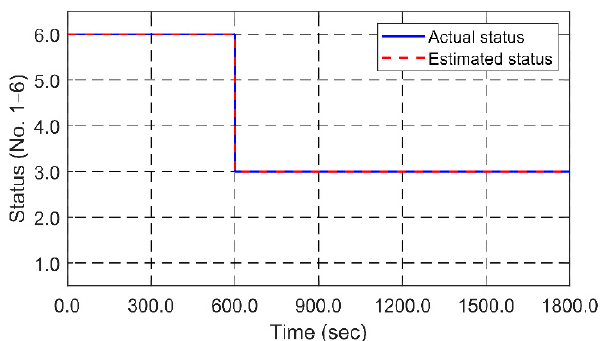
Figure 21. Time histories of failure detection status when both mooring lines at Y = − 50 m are broken after 600 s ( H s = 2.5 m, T p = 7.5 s, current velocity = 0.6 m/s). Status 3 indicates the Output 3 case.